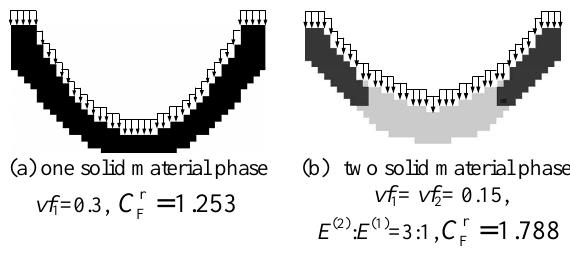
Fig. 12 2D optimal configurations of model 2 under pres-